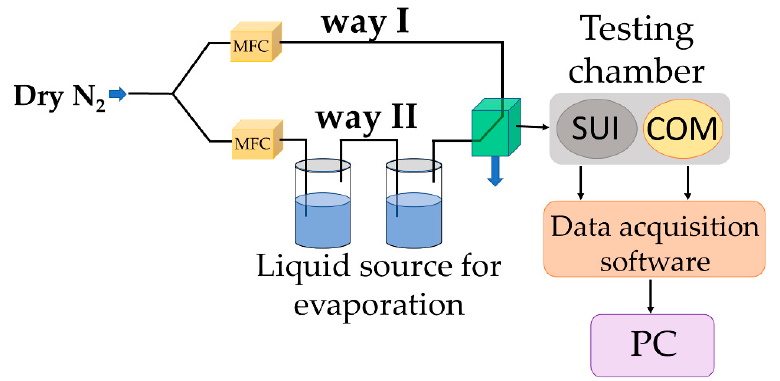
Figure 2. The layout of the sensing structure (the distance between the metallic interdigitated (IDT) dual-comb structure fingers is 10 µm).